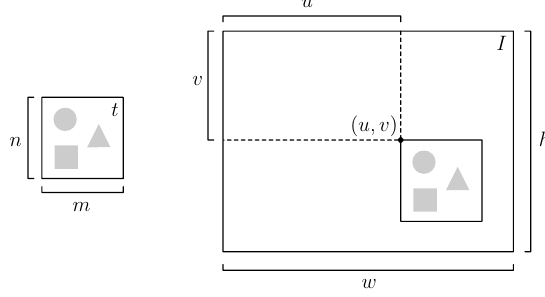
n which has point ( u , v ) as ×